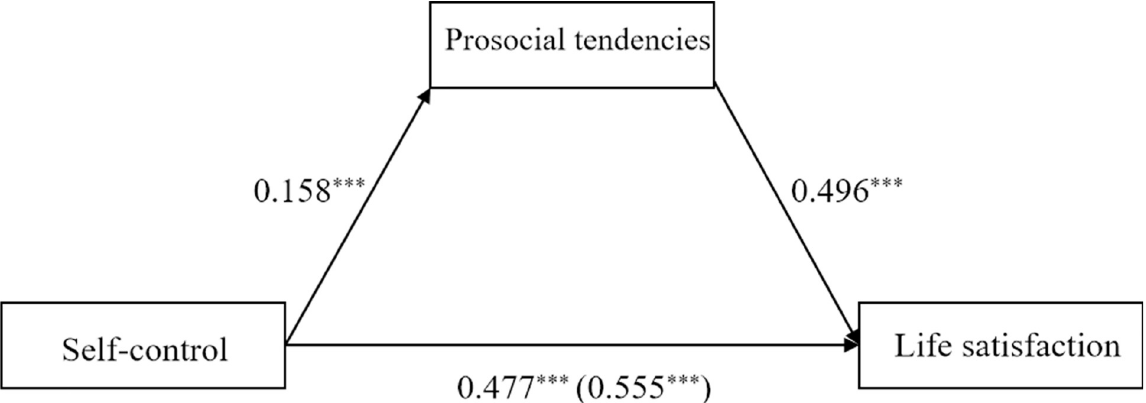
Fig 3. Mediation of prosocial tendencies between self-control and life satisfaction in university students (sample 2). Note: ��� p < 0.001; value in parenthesis represents total effect.